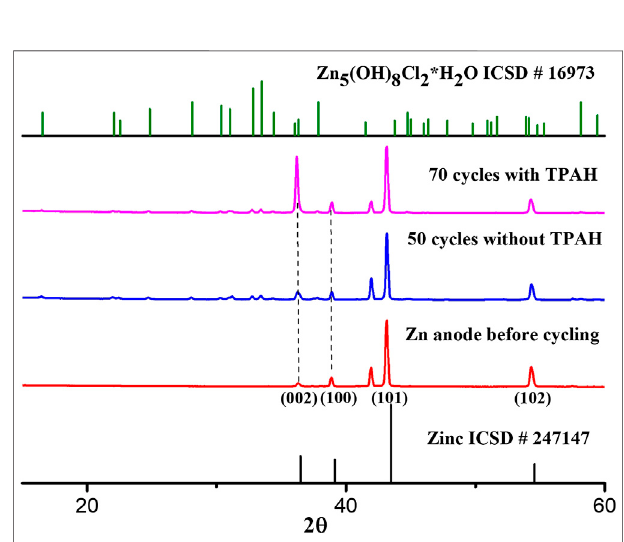
FIGURE 4 | XRD patterns of Zn electrodes before and after cycling with and without TPAH additive.